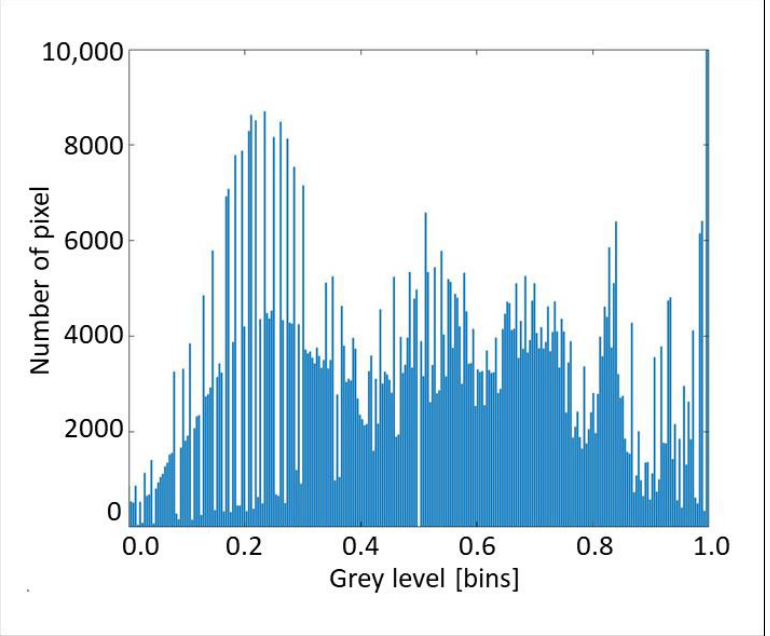
Figure 18. Histogram of grey scale vs. number of pixels for section B1 concerning layers and waves.